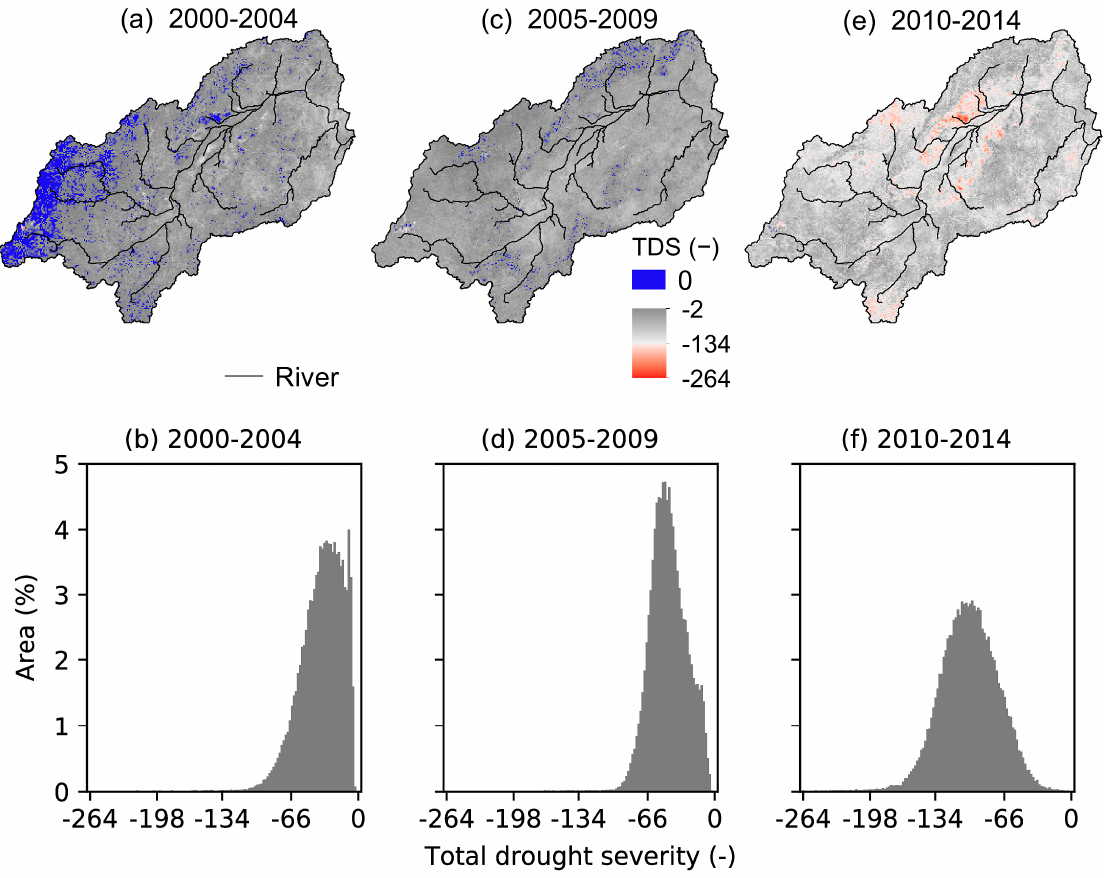
Figure 7. Map ( a ) and histogram ( b ) of total drought severity (TDS) during the first quinquennium. Map ( c ) and histogram ( d ) of TDS during the second quinquennium. Map ( e ) and histogram ( f ) of TDS during the third quinquennium.